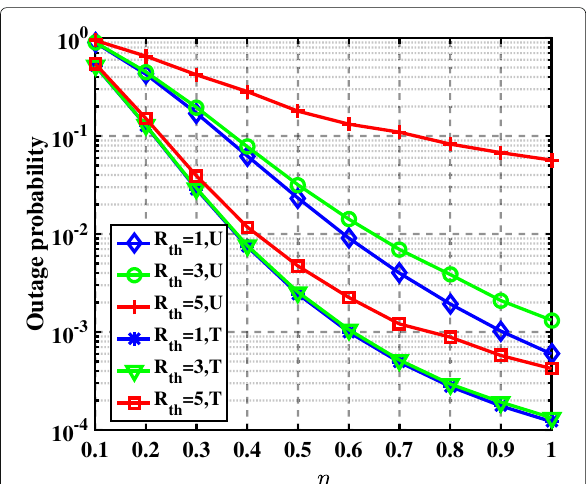
Fig. 9 Outage probability vs. η for untrusted SUs with different power